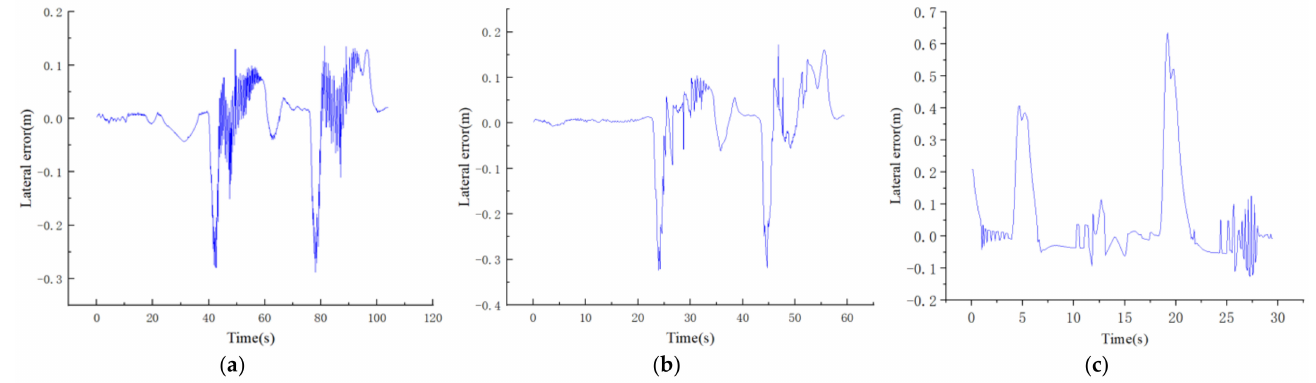
Figure 9. Lateral error of tracking at ( a ) 4 m/s, ( b ) m/s, and ( c ) 10